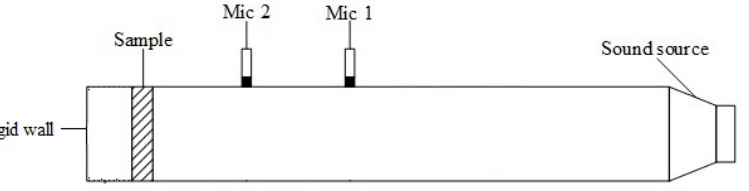
Figure 3. An impedance tube configured with two microphones.